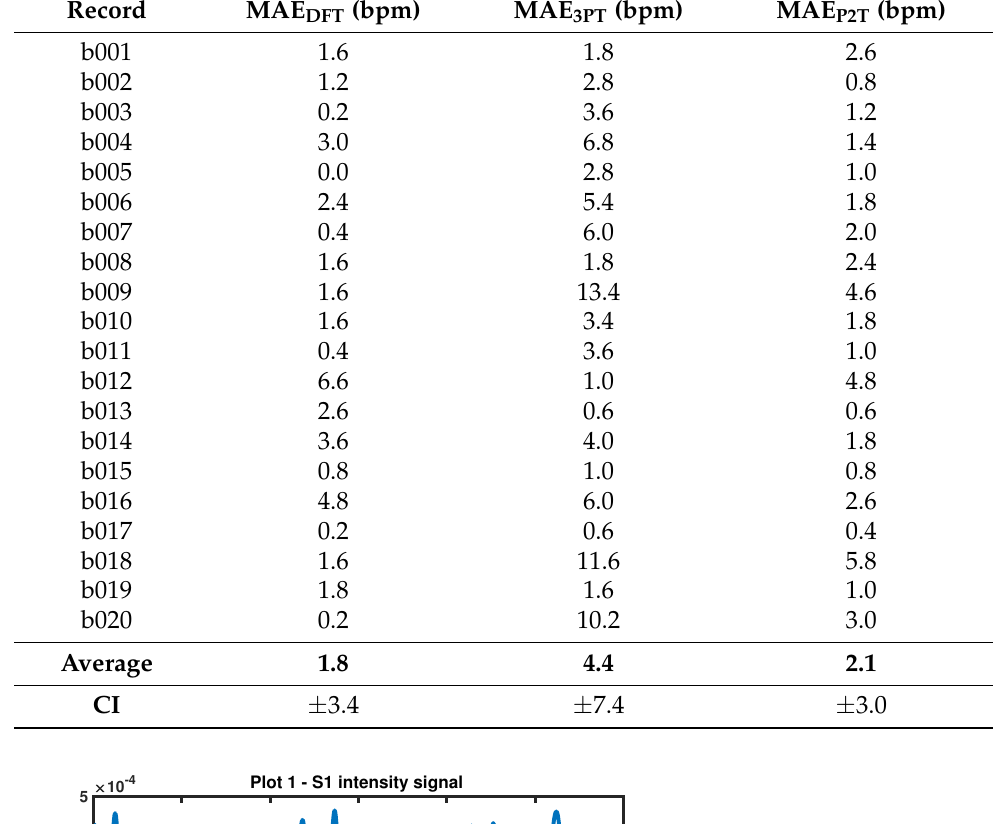
Table 4. S1/S2 Intensity performance.